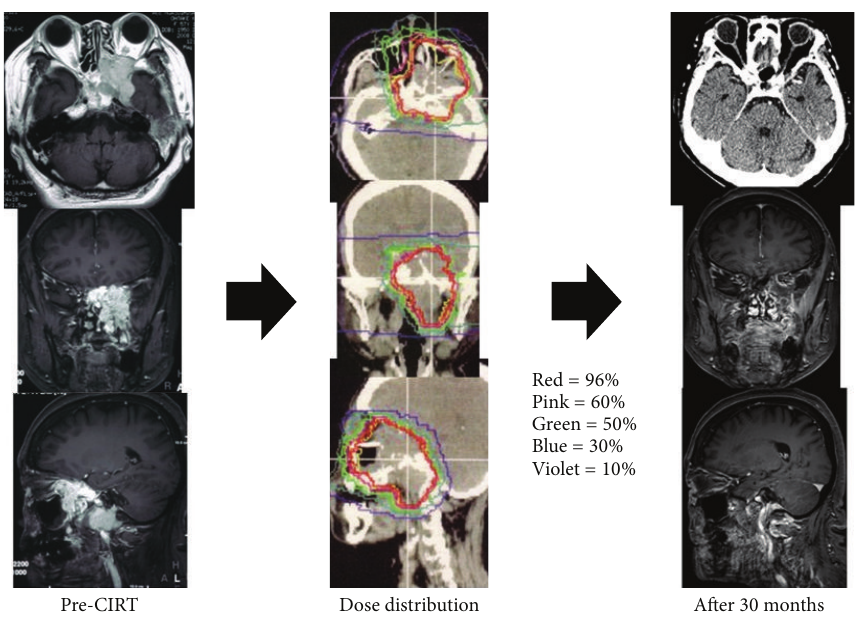
Figure 2: A 43-year-old Japanese female with adenoid cystic carcinoma in skull base. Axial, coronal, and sagittal contrast T1-weighted magnetic resonance image before carbon ion beam radiotherapy, dose distribution of carbon ion radiotherapy in axial CT image, and axial contrast-enhanced T1-wighted magnetic resonance image 30 months after carbon ion radiotherapy show enhancement and edema. This patient received no treatment for cerebral radiation injury. CIRT: carbon ion beam